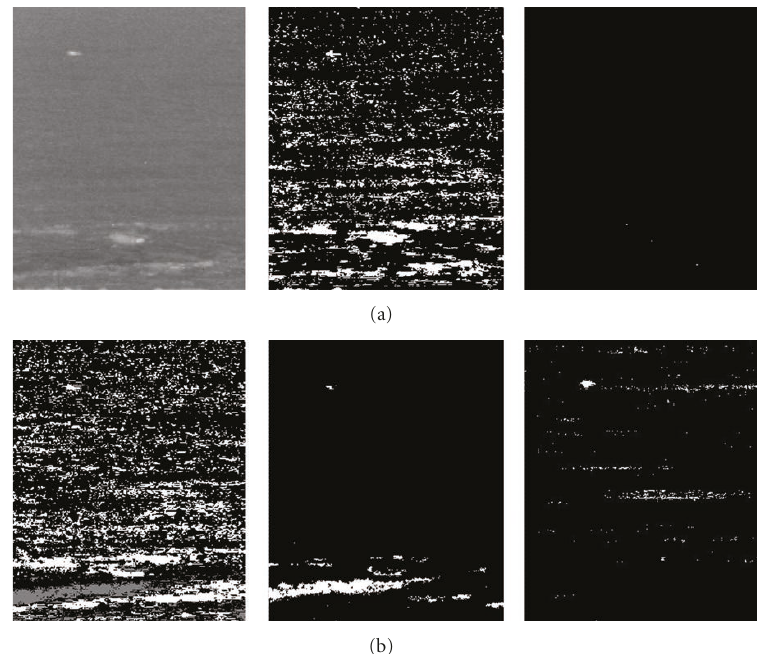
Figure 5: MW01 sequence in the 3–5 μ m band. From left to right, (a): original, mean, gmm. (b): EGMM, ViBe, behaviour subtraction.